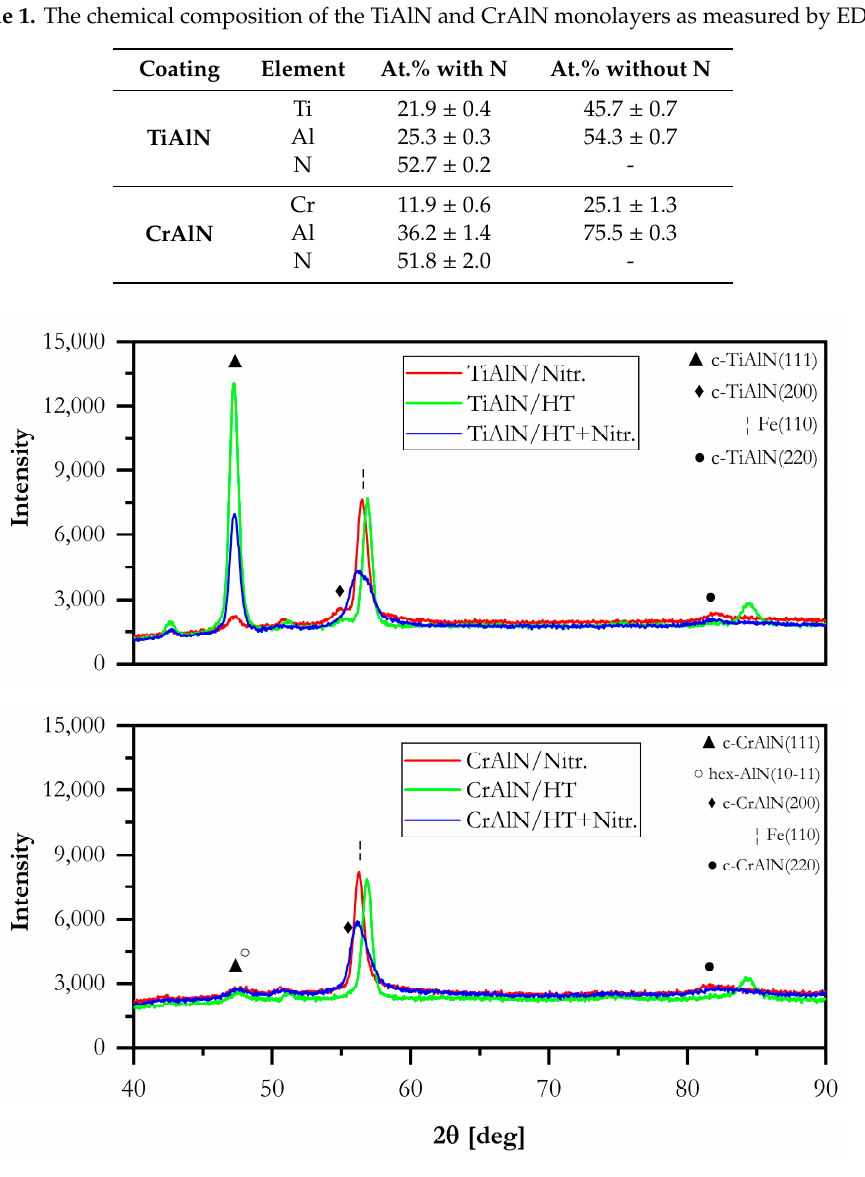
Figure 4. X-ray phase diffractogram of the TiAlN (above) and CrAlN (below) coatings on the different substrates, using Fe-K α radiation.